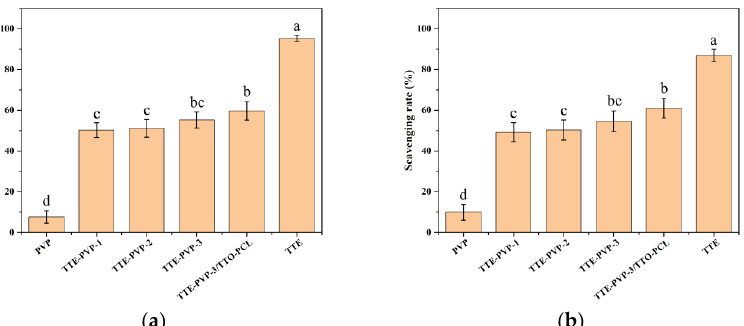
Figure 4. Scavenging capacities for ( a ) DPPH and ( b ) hydroxyl free radicals. Values are given as mean ± SD from three independent replications; different lowercase letters on the bars show significant difference at p < 0.05.